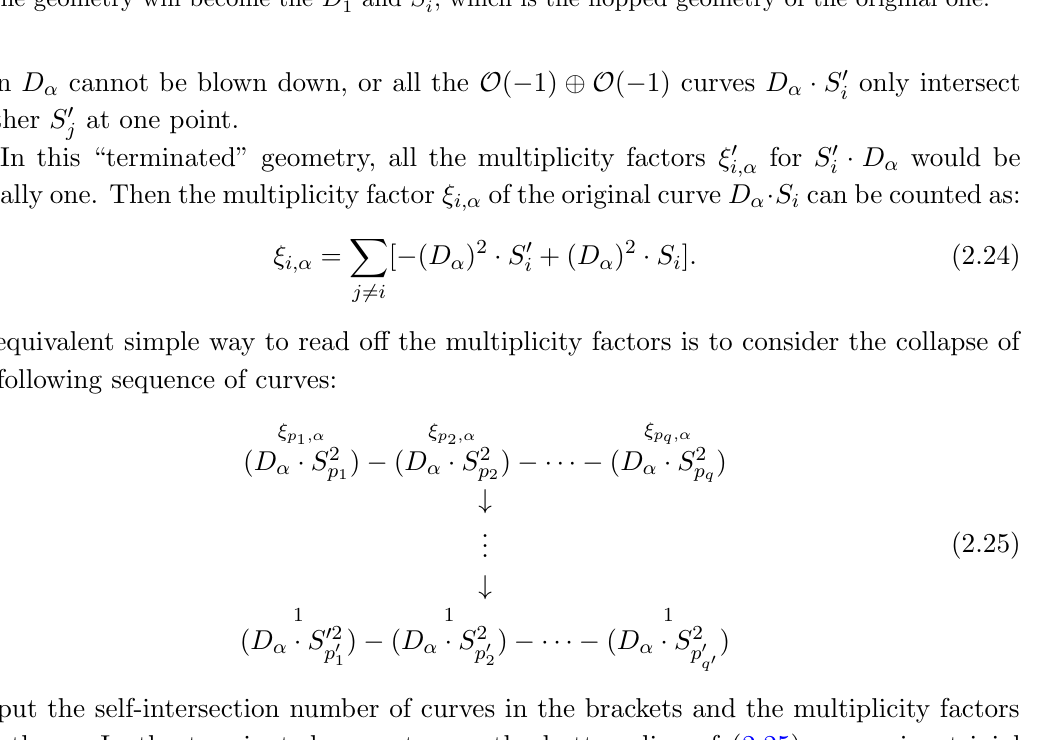
Figure 1. The (cid:13)op operation on an example with D 2 (cid:1) S 3 = (cid:0) 1, D 1 (cid:1) S 1 (cid:1) S 3 = 1 and D 1 (cid:1) S 2 (cid:1) S 3 = 1. 1 In the picture, each line segment denotes an intersection curve S (cid:1) S 0 , and the integer label on the side of S (or S 0 ) is the triple intersection number S (cid:1) ( S 0 ) 2 (or S 0 (cid:1) S 2 ). After shrinking the curve D 1 (cid:1) S 3 , the surface geometry of ~ D 1 and ~ S i has a conifold singularity. Then after blowing up ~ S 1 and ~ S 0 and S 0 , which is the (cid:13)opped geometry of the original 2 , the geometry will become the D 1 i